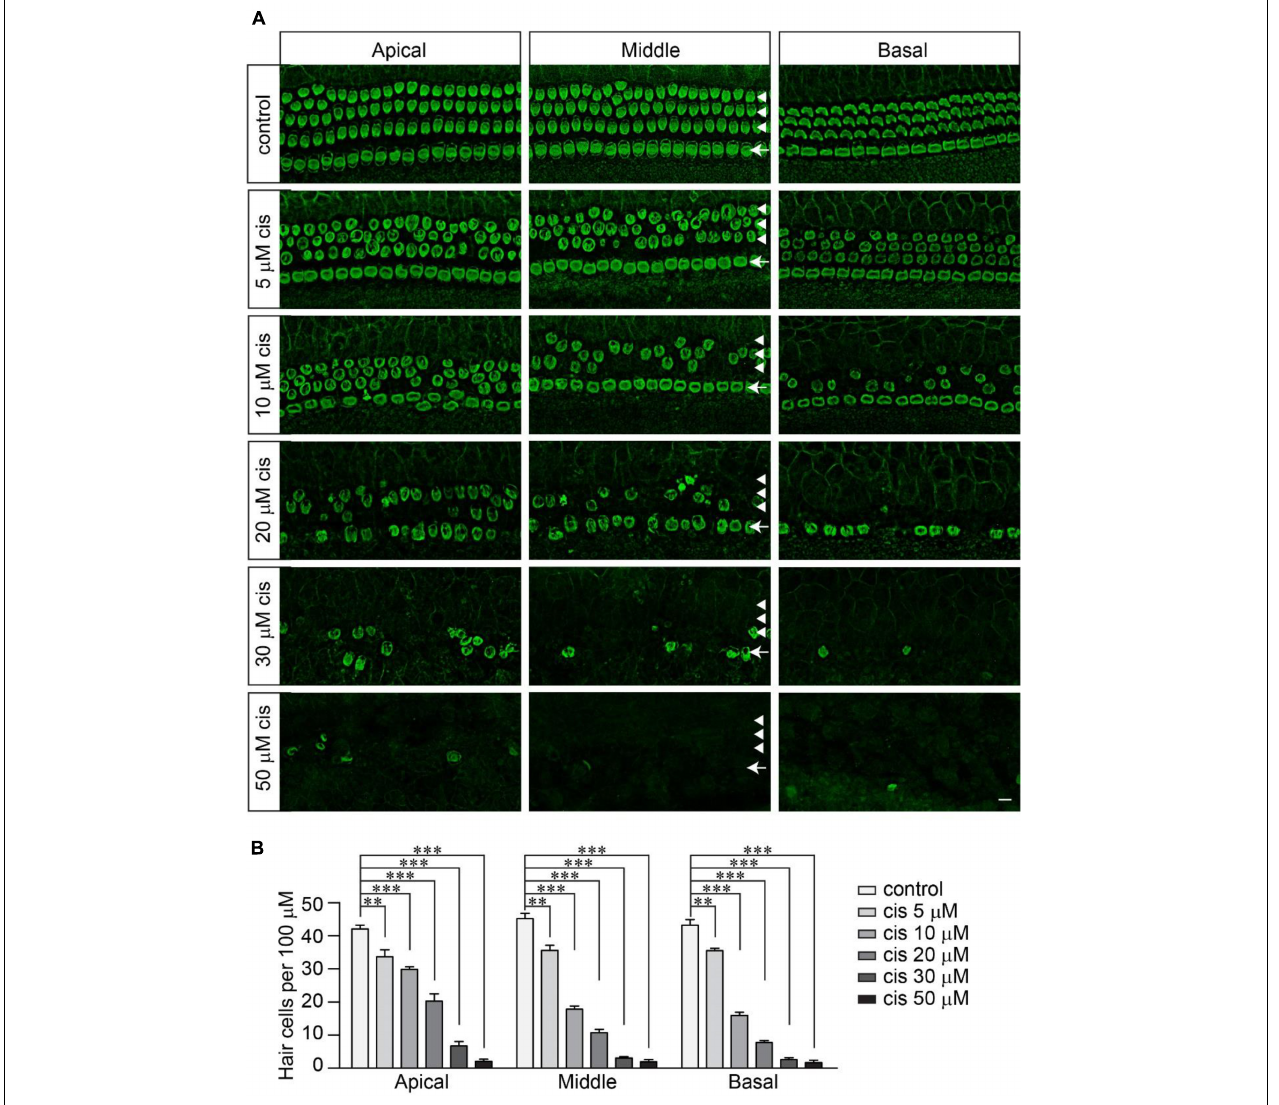
FIGURE 1 | Cisplatin dose-dependently kills wild-type murine hair cells. (A) Cochlear explants were dissected from P3 wild-type C57/BL6J mice and cultured overnight in DMEM/F12 culture medium. Then, the cochlear explants were exposed to cisplatin at different concentrations for 2 days. The samples were fixed and labeled with an antibody against β 2-spectrin, a hair cell marker. Note, OHCs (arrowheads) were more susceptible to cisplatin than IHCs (arrows). Scale bar: 10 µ m. (B) Numbers of hair cells per 100 µ m (3 mice per group). Data are represented as the mean ± standard error (SE). Two-way ANOVA followed by Bonferroni post hoc test was performed ( ∗∗ p < 0.01 and ∗∗∗ p <